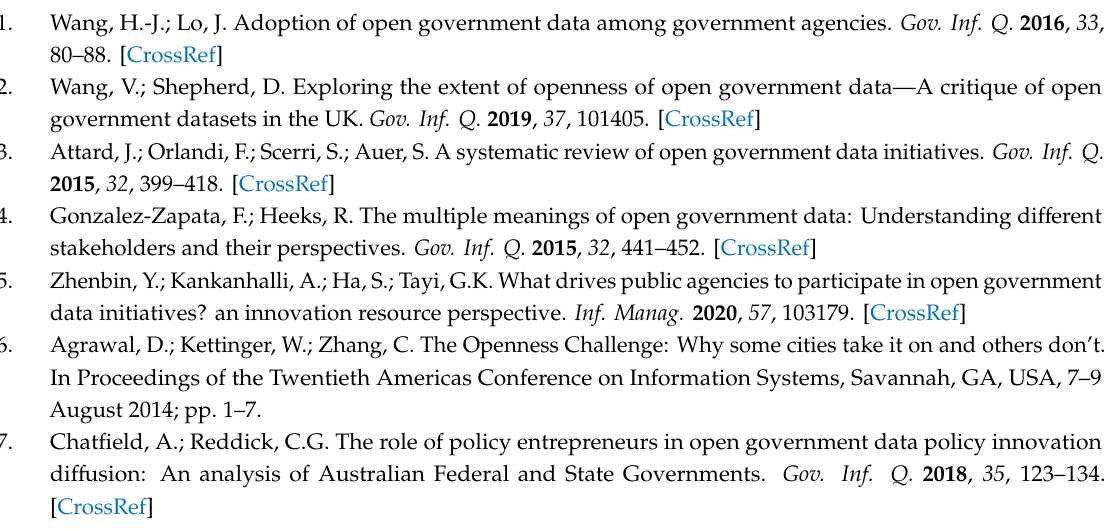
Table S1: Consolidated Dataset on General